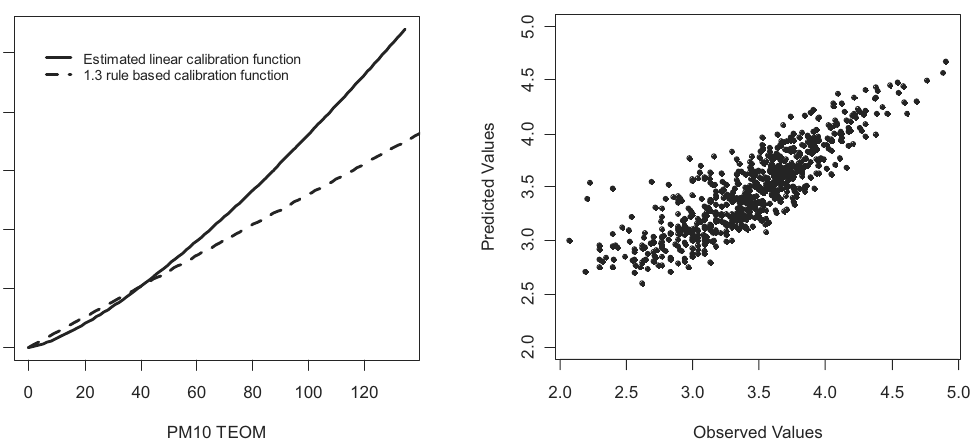
Figure 2 – The estimated calibration function and the “1.3 rule” calibration function.